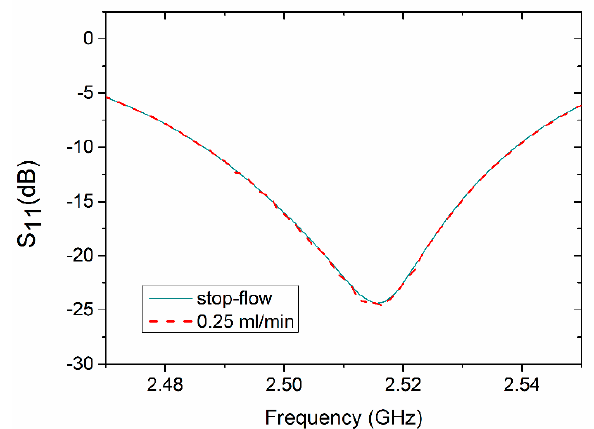
Figure 10. Reflection coefficient of the resonator-based sensor measured for stop-flow and continuous flow modes.